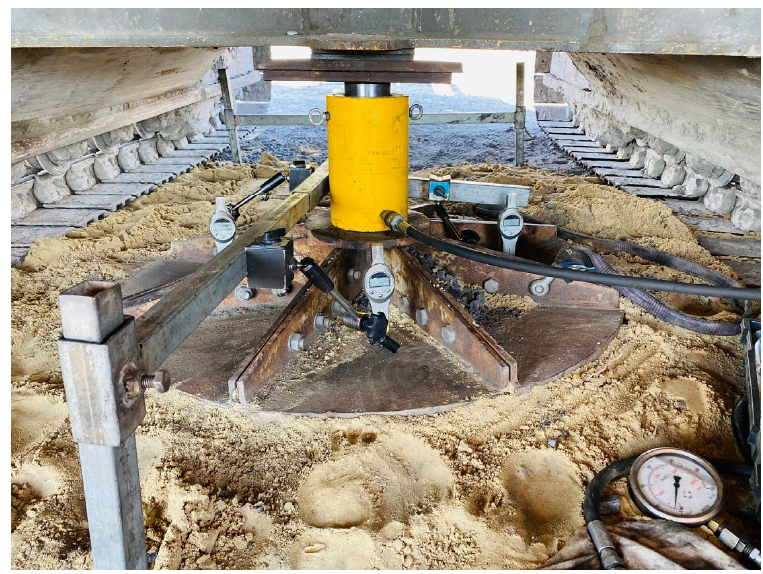
Figure 24. A rigid plate with an area of 1 m 2 for subsoil acceptance tests after improvement using the RIC method (Photo by P. Dobrzycki).